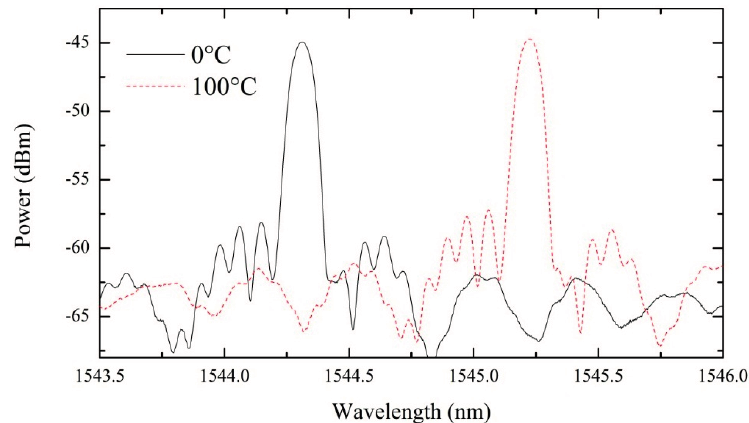
Figure 5. Reflection optical spectra for one FBG at 0 °C and 100 °C.